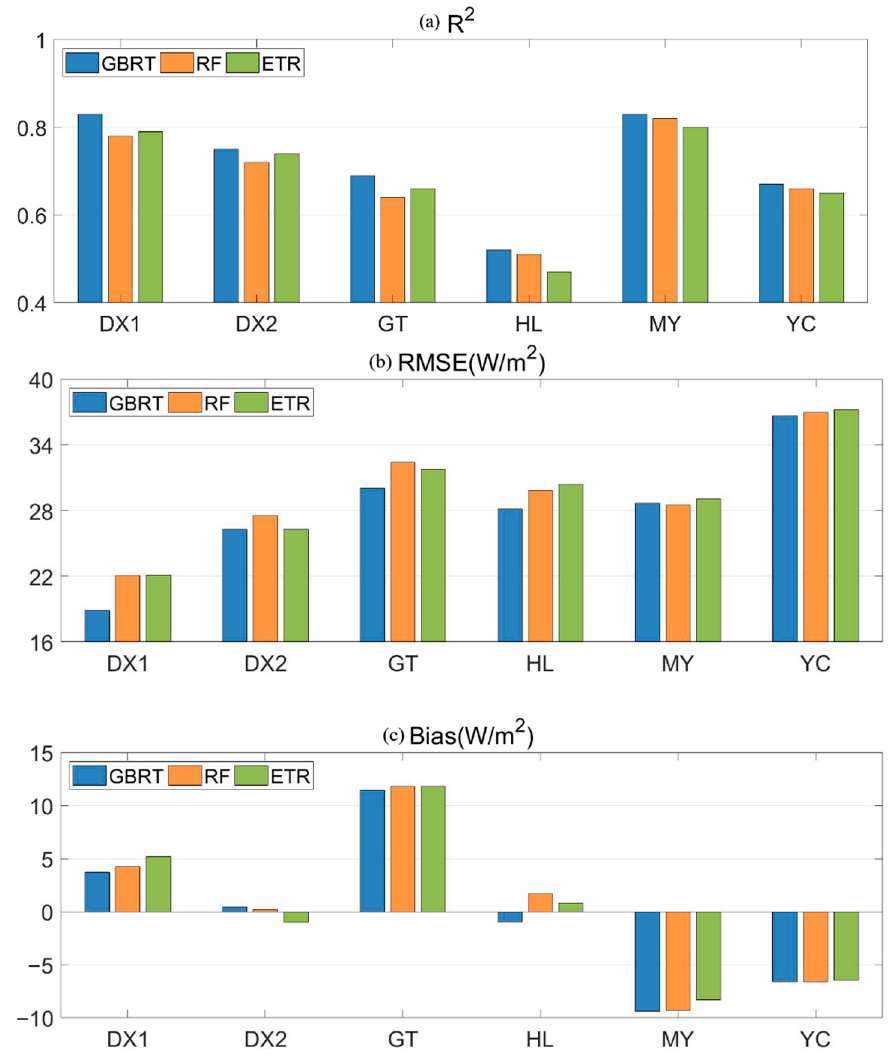
Figure 6. The performance indices result of the testing data of the second cross-validation experiment (one site was tested, and the other sites were trained, circulating six times) of each site for three machine-learning algorithms. ( a ): R 2 ; ( b ): RMSE; ( c ): Bias.